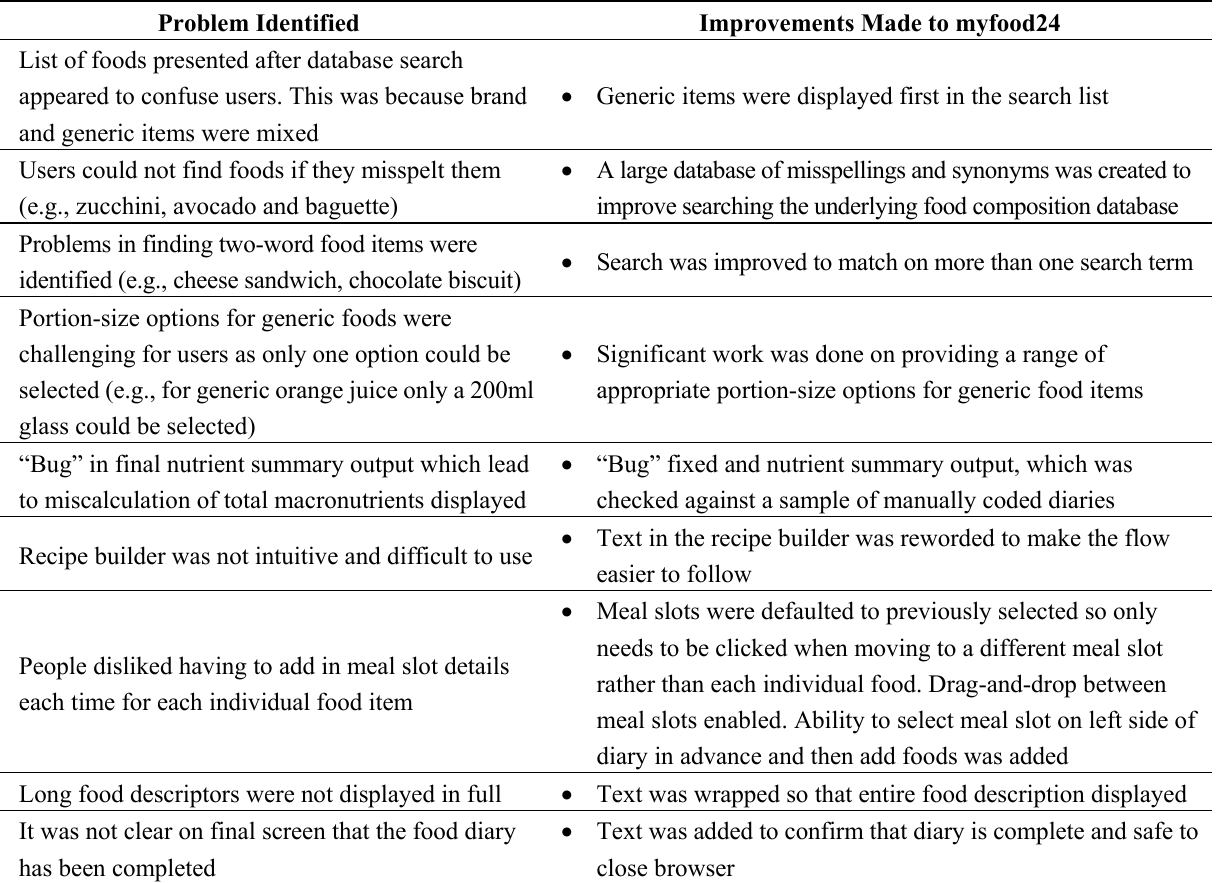
Table 3. Key issues identified with the beta version of myfood24 during usability